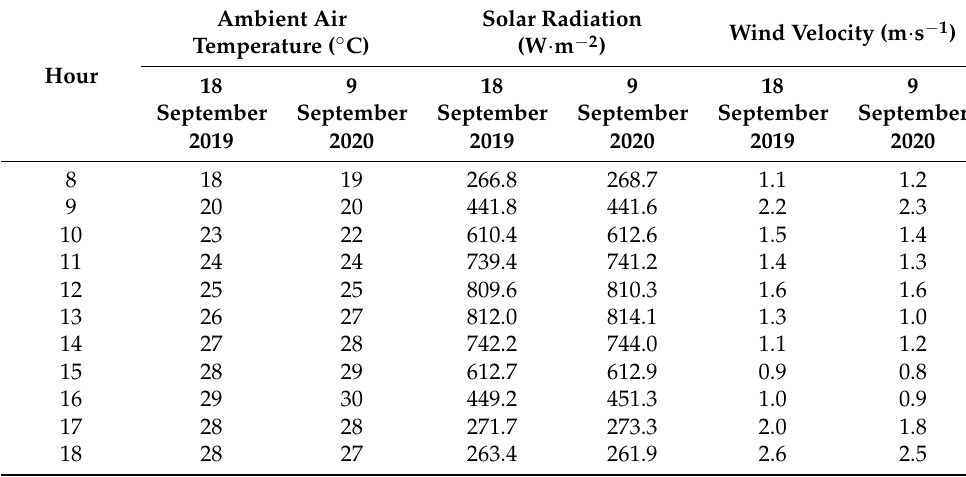
Table 2. The hourly values of the significant data measured during the